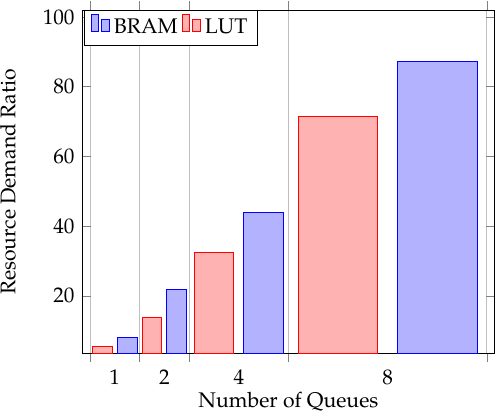
Figure 5. FPGA resource requirement for various queues (In